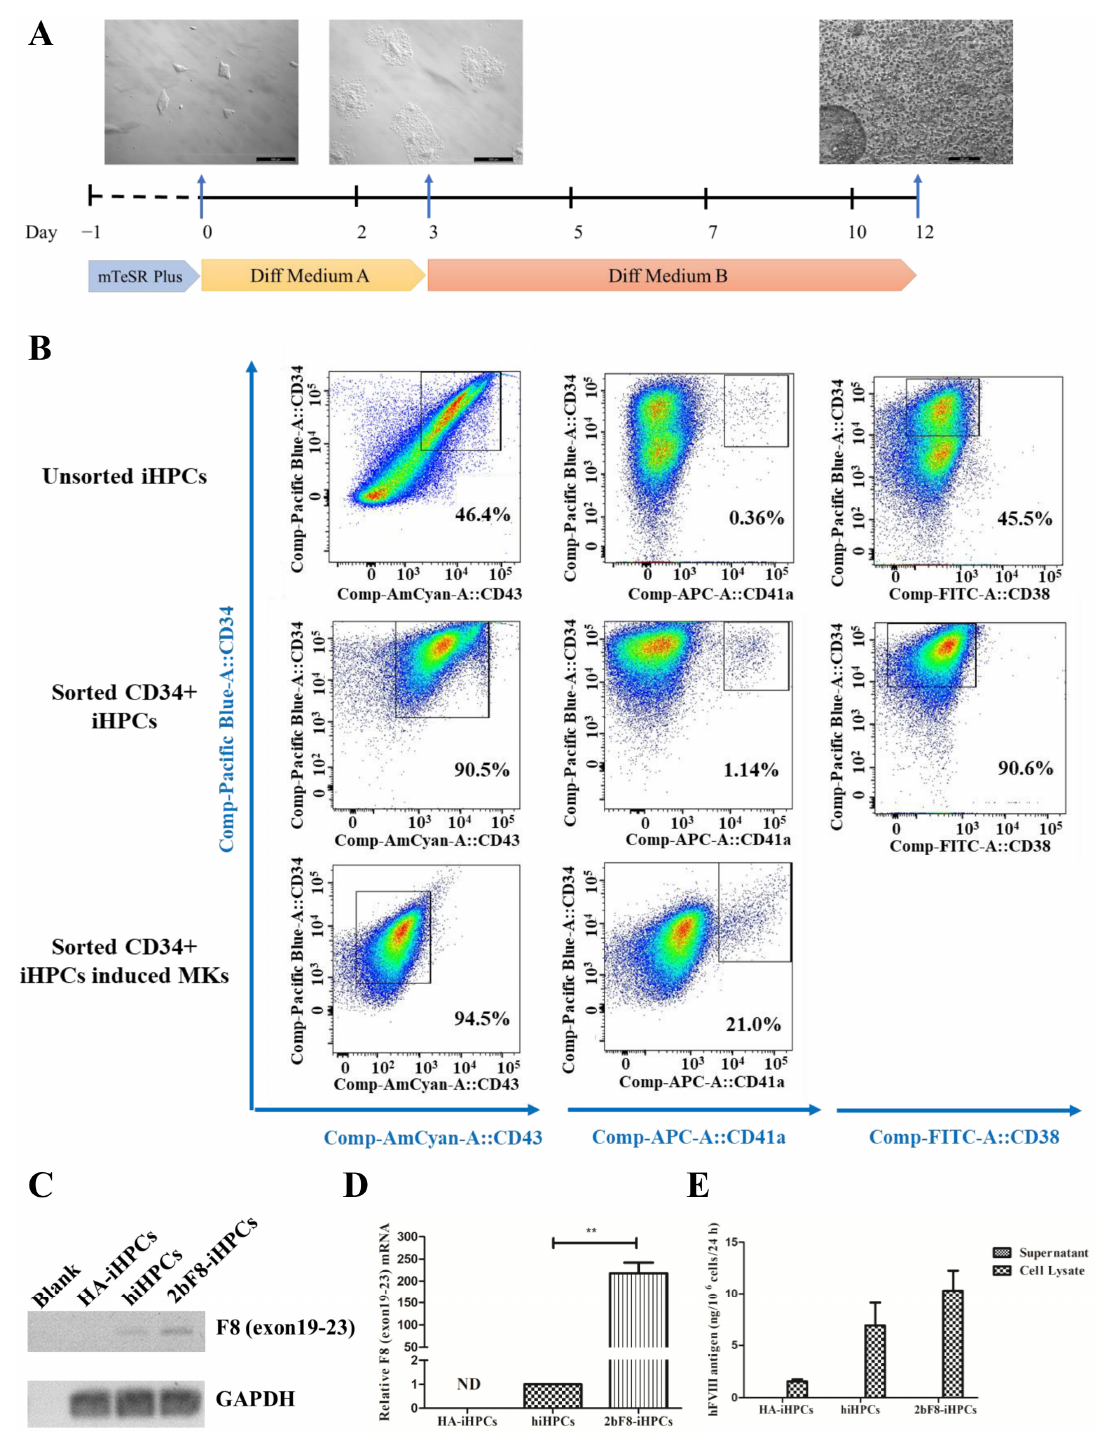
Figure 4. Generation and characterization of iHPCs and iMKs derived from hiPSCs and verification of F8 expression in F8 -modified iHPCs and iMKs. ( A ) Flow chart of the protocol for differentiation of hiPSCs into iHPCs and dynamic change in cellular morphology during the differentiation (day 0, 3, 12). ( B ) Flow cytometry analysis of iHPCs and iMKs derived from hiPSCs. ( C ) F8 expression in HA- iHPCs, hiHPCs, and 2bF8-iHPCs according to RT-PCR. ( D ) Relative expression of F8 in HA-iHPCs,